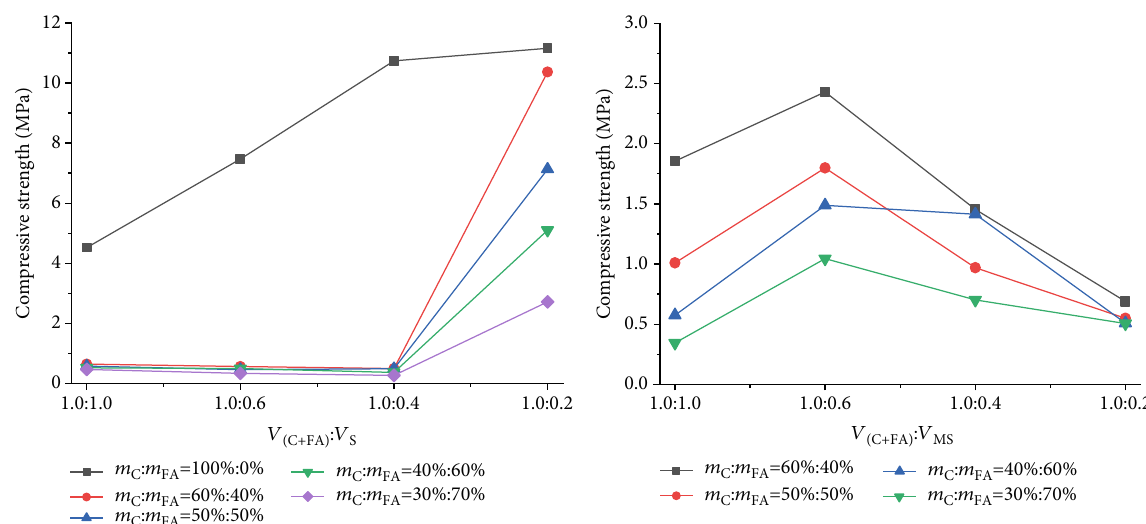
: m is the mass ratio of cement to fl y ash in solid powder; V ð C FA : V is the volume ratio of cement- fl y ash slurry to modi fi ed C+FA Þ MS